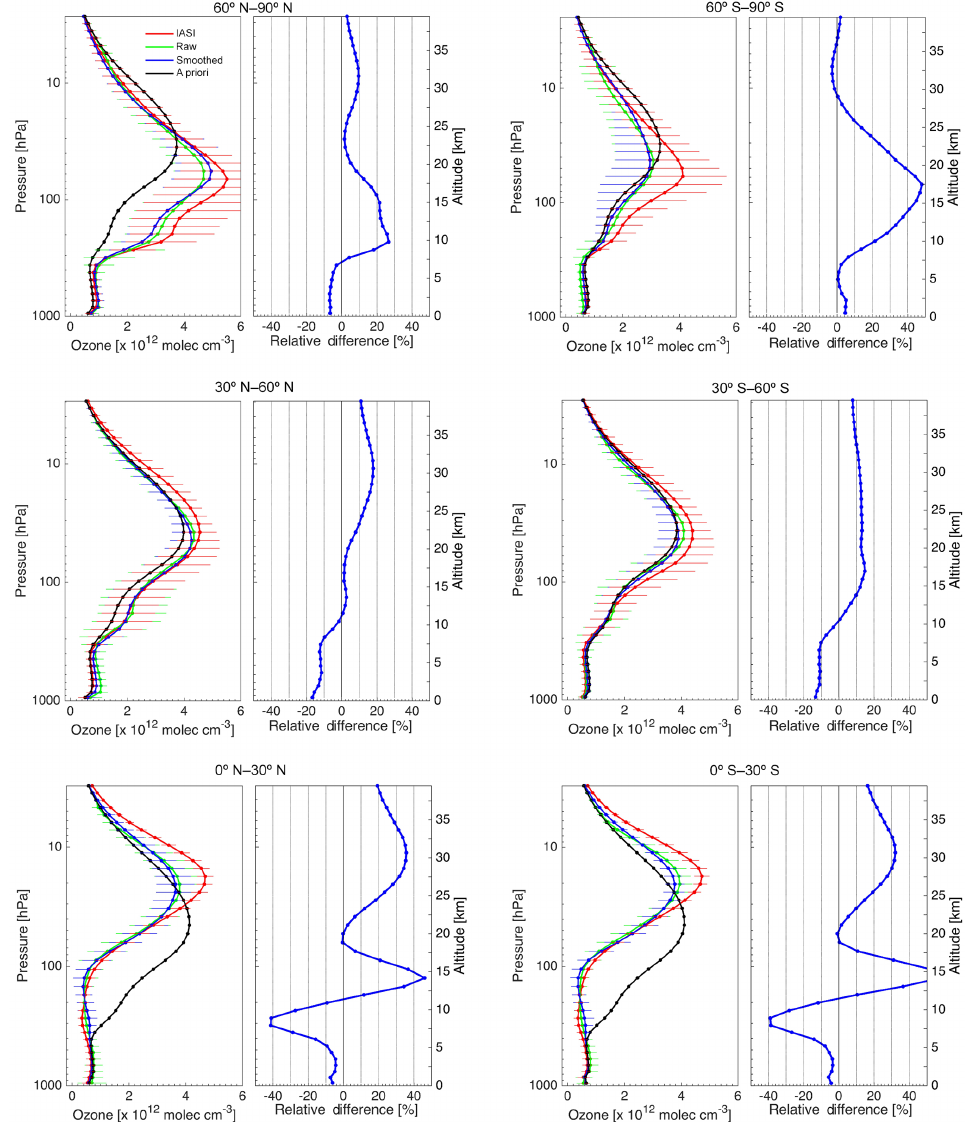
Figure 14. Left panels: mean ozone vertical profiles retrieved by IASI-A (red), observed by the ozonesondes (green), and observed by the ozonesondes after application of the IASI averaging kernels (blue) for 30 ◦ latitude bands. The black line indicates the a priori O 3 profiles as used in the IASI retrieval with FORLI. Right panels: vertical profiles of the relative difference (in percent) between the IASI retrieved mean profile and the smoothed ozonesonde mean